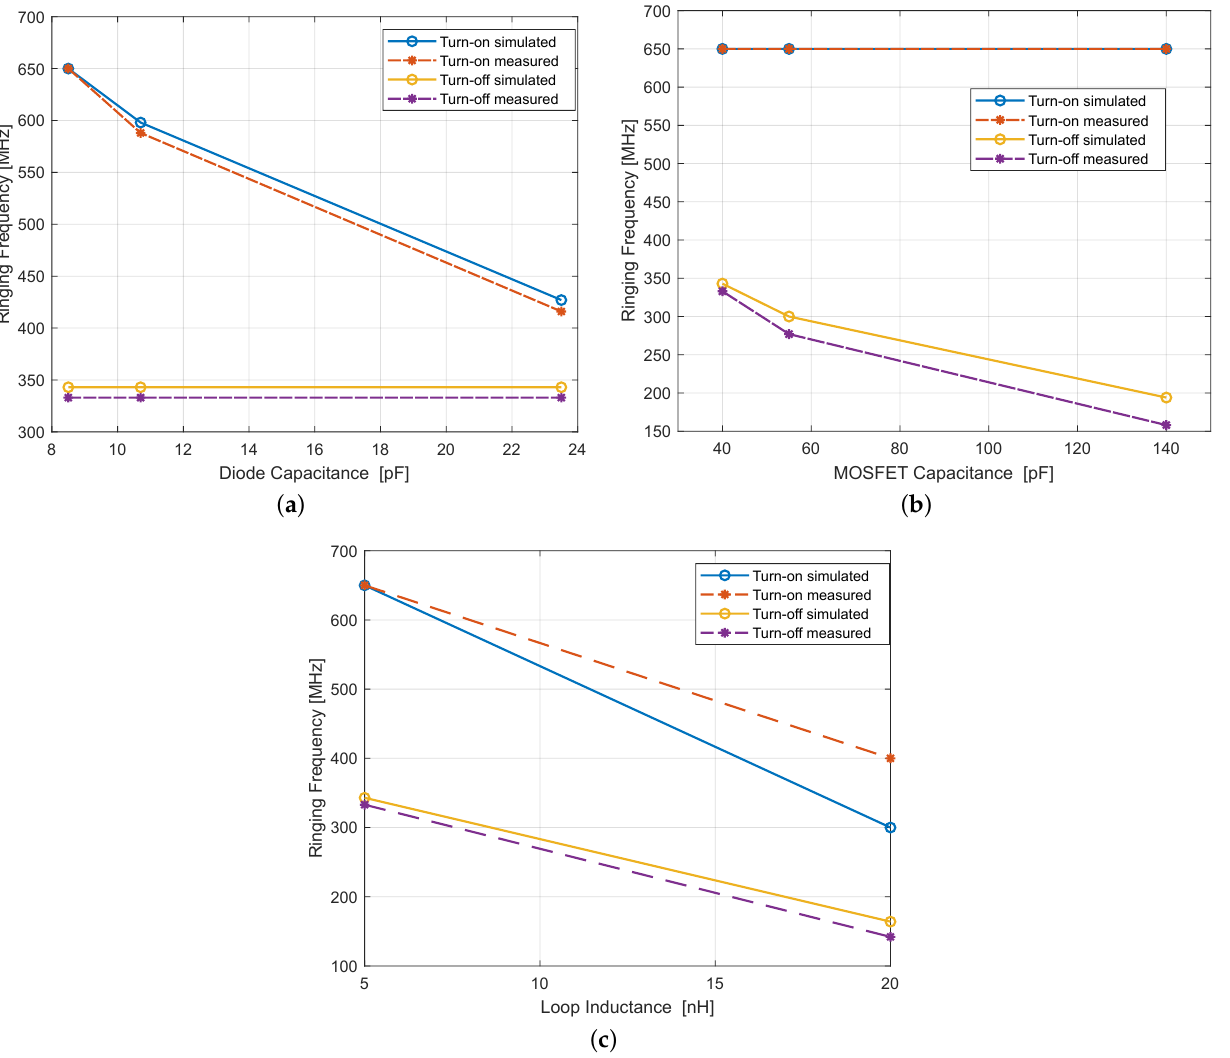
Figure 13. Comparison of the measurement and simulation of the influence of the parasitic elements on the ringing frequency during turn-on and turn-off. ( a ) Simulated and measured ringing frequency using different capacitance values across the diode and ( b ) across the MOSFET; ( c ) simulated and measured ringing frequency using different values for the loop